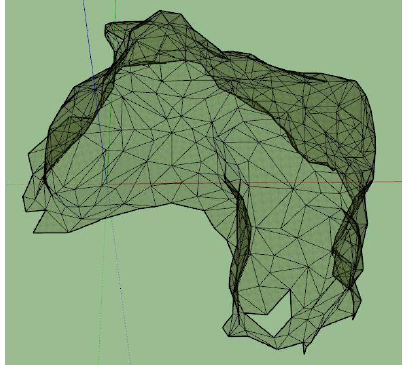
Figure 5. Isolated tree crown as viewed in SketchUp